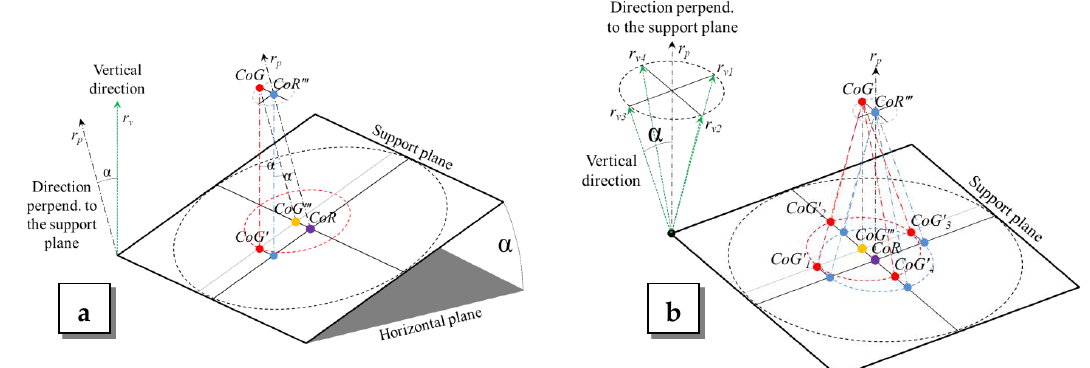
Figure 11. Determination of the trajectories followed by CoG′ during a complete rotation of the turntable around r p when the support plane is inclined at an angle α ; ( a ) starting situation; ( b ) trajectories described by CoG′ around CoG″ for a complete (counter-clockwise) rotation of the turntable around CoR (or, better, around the axis passing through CoR and CoR″, perpendicular to the support plane). The numerical sequence of the subscripts indicates the direction of the travel of CoG′.